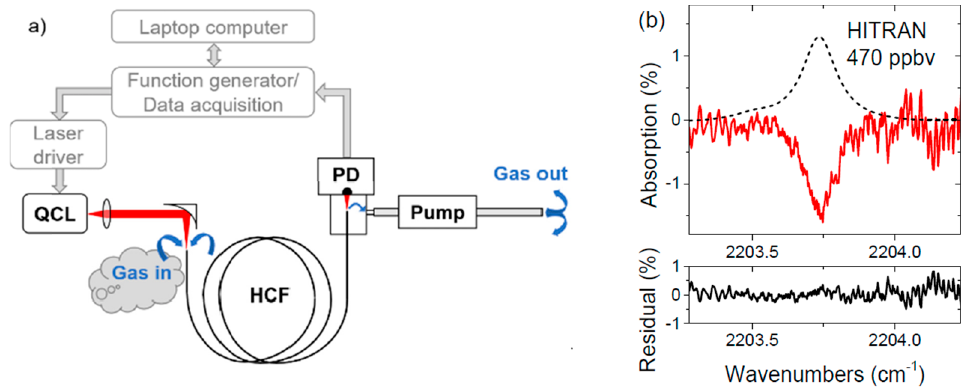
Figure 14. ( a ) A schematic diagram of the setup used in [67] for the laser spectroscopy of nitrous oxide. The hollow-core fiber used in this work has already been shown in Figure 11c; ( b ) direct laser absorption spectrum (solid line) and model (based on HITRAN database; dashed line) for the trace concentration of N 2 O. Fitting residual is shown below. Reprinted with permission from [67], © The Optical Society.